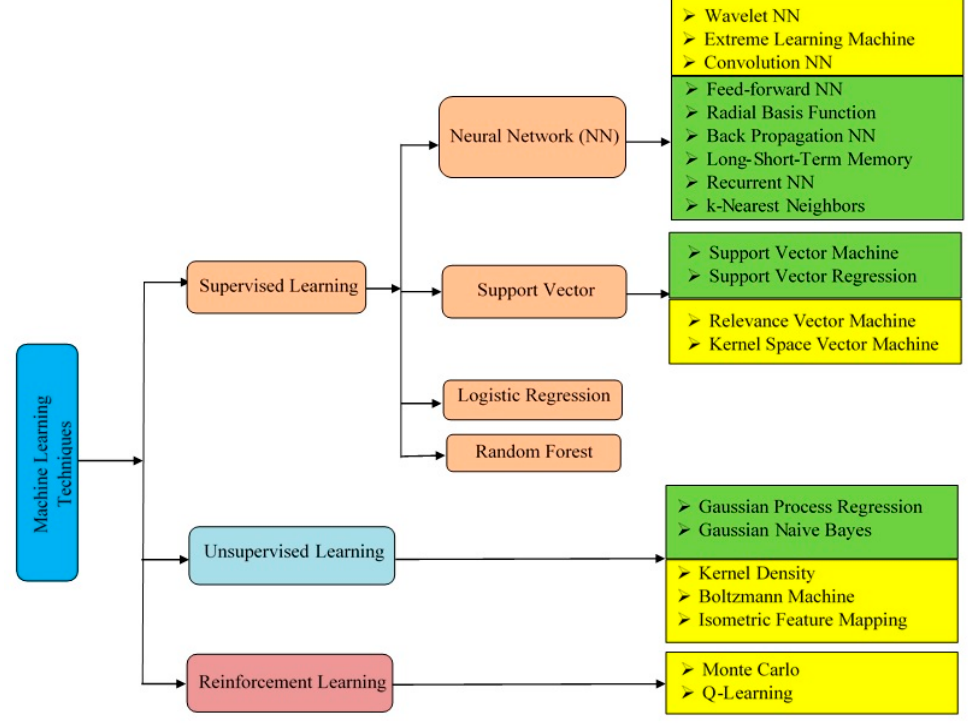
Figure 3. A complete family of ML approaches, used in BMS of LIB.